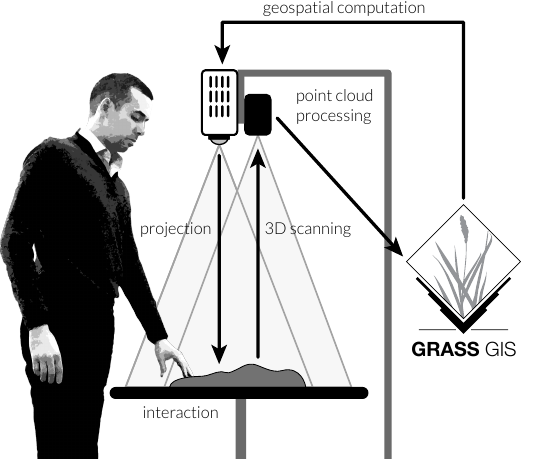
Figure 2: How Tangible Landscape works: a near real-time feedback cycle of interaction, 3D scanning, point cloud processing, geospatial computation, and projection